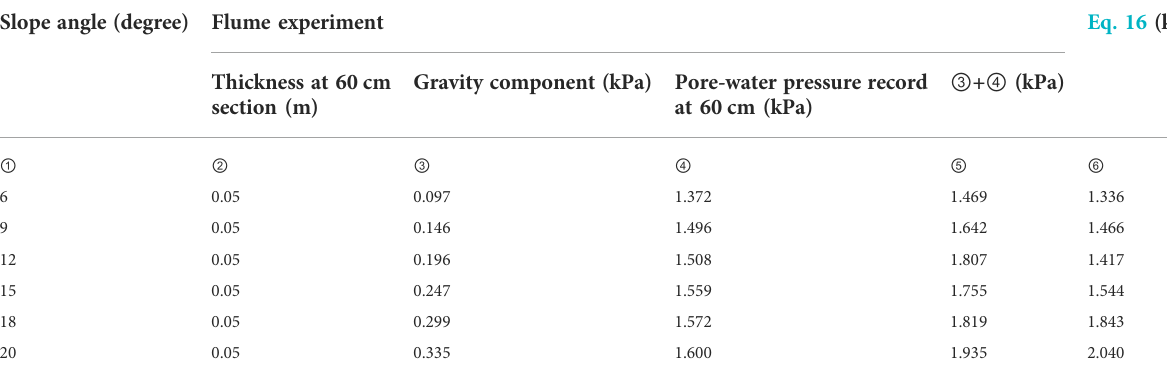
TABLE 4 Comparison of experiment value and calculation value under saturated seepage in 60 cm